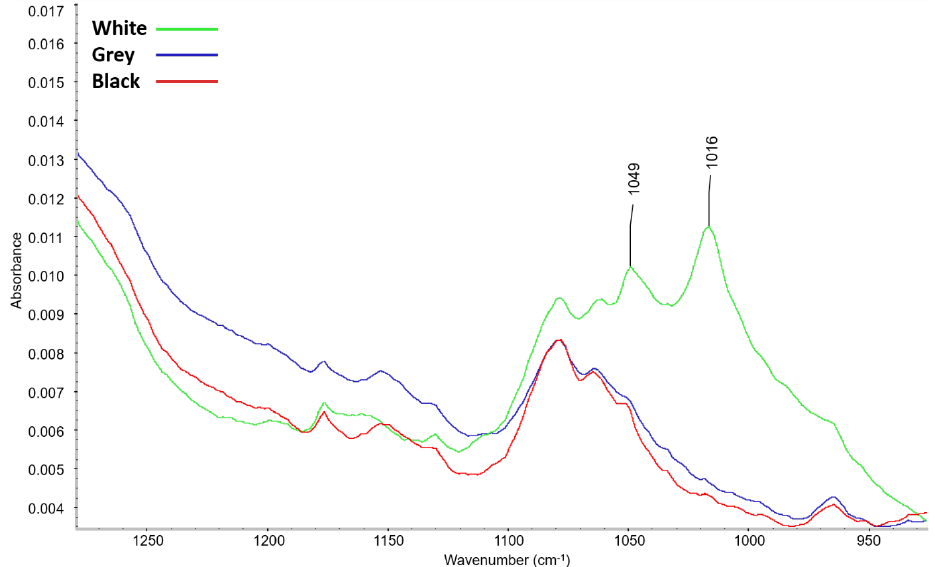
Figure 6. Details of the 1200 – 900 cm −1 range of ATR-FTIR spectra of the tested PE foams after artifi- cial aging.